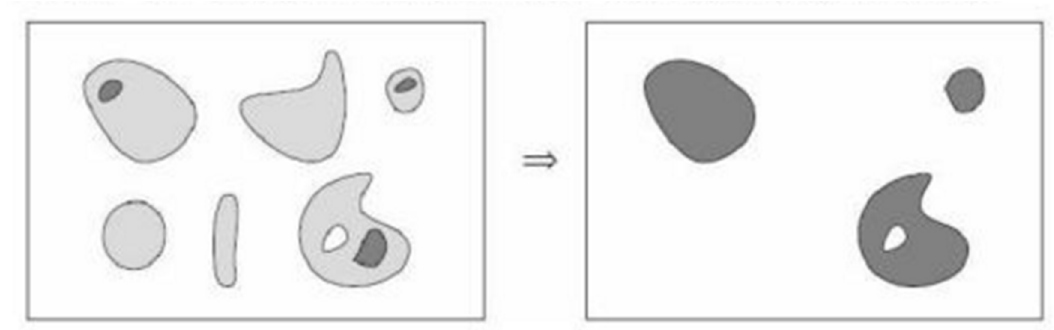
Figure 2. Morphological reconstruction.